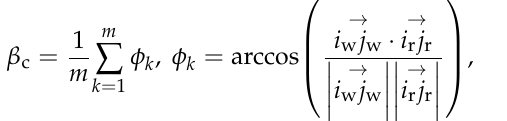
Figure 6. Matching between scaled image and watermarked image: ( a ) scaled image (0.5); ( b ) feature matching.